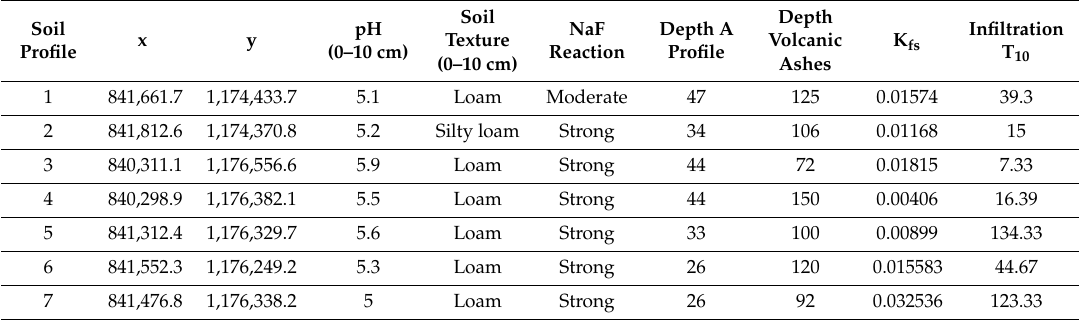
Table1. Soilprofiledescriptionsandassociatedhydrologicalandpedologicalvariables. Kfs: field-saturated soil hydraulic